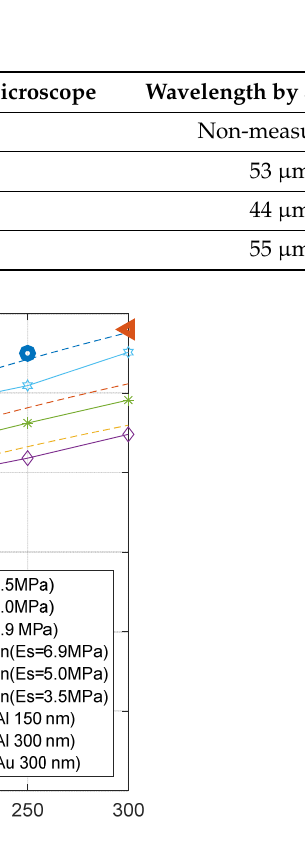
10 of 12 Table 1. Wavelength of the wrinkling metal pa tt ern. Thin Films